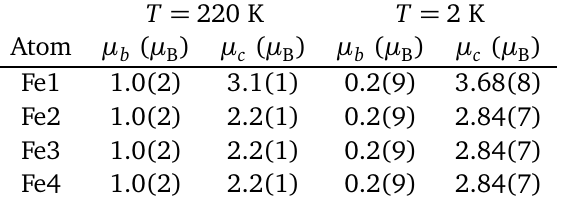
and µ correspond to b c